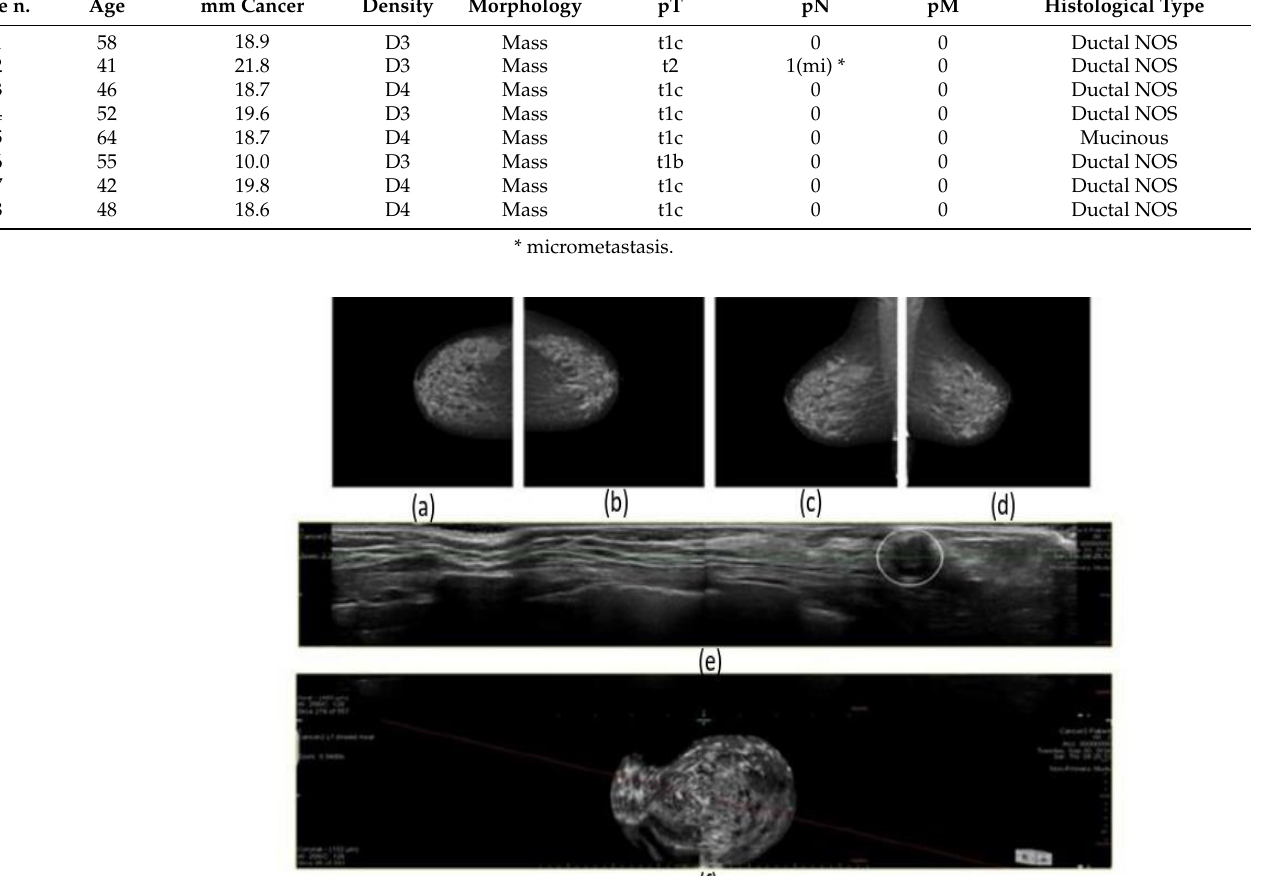
Table 4. Distribution of cancers detected by 3D prone ABUS performed after negative mammography. Case n.